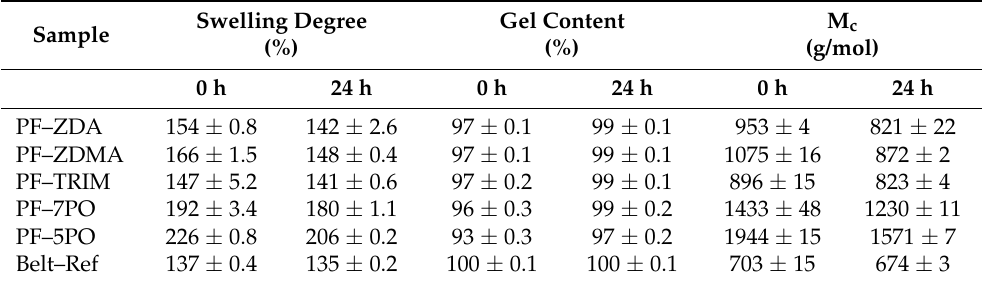
Figure 3. Schematic representation of ( a ) curing rheogram, ( b ) tensile properties, ( c ) storage modulus, and ( d ) tan δ based on DMTA results of EPDM–PF compounds. Table 7. Swelling degree of hybrid-reinforced EPDM compounds prior to and after postcuring for 24 h at 150 ◦